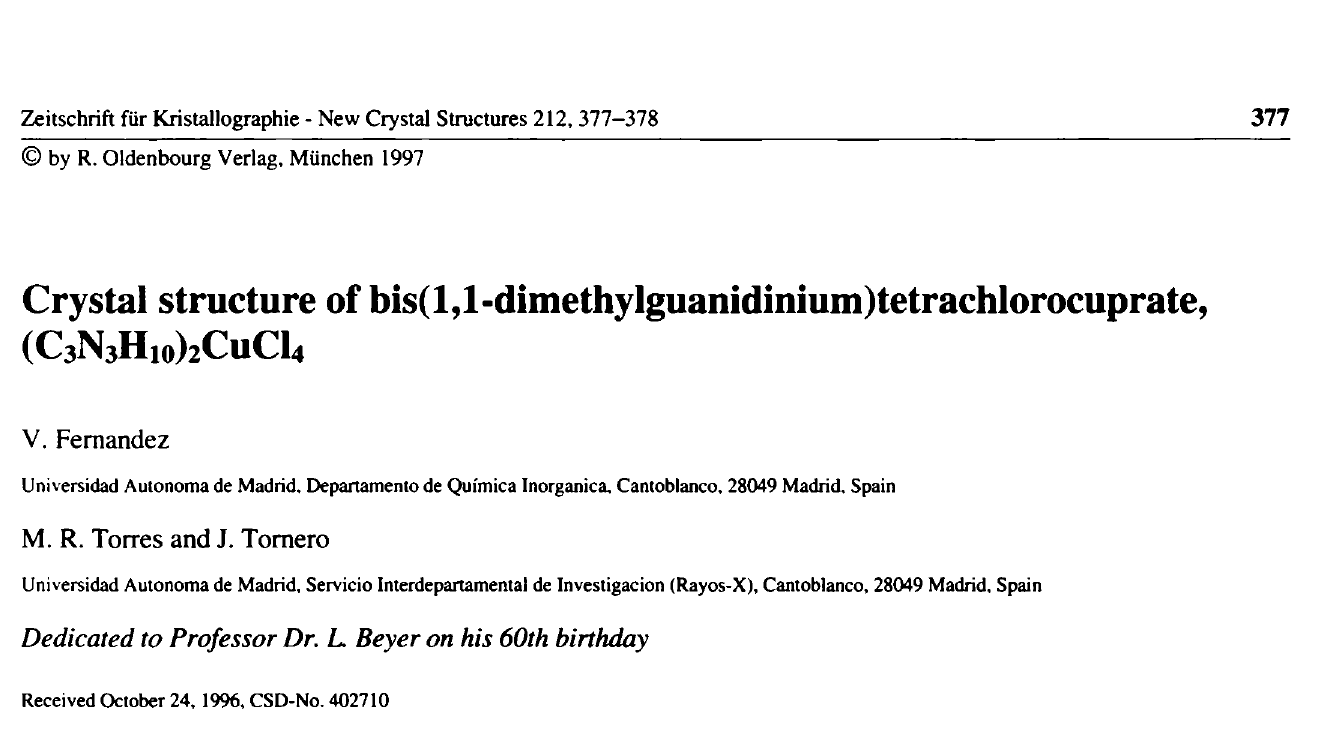
Fig. 1. Packing diagram of the compound.